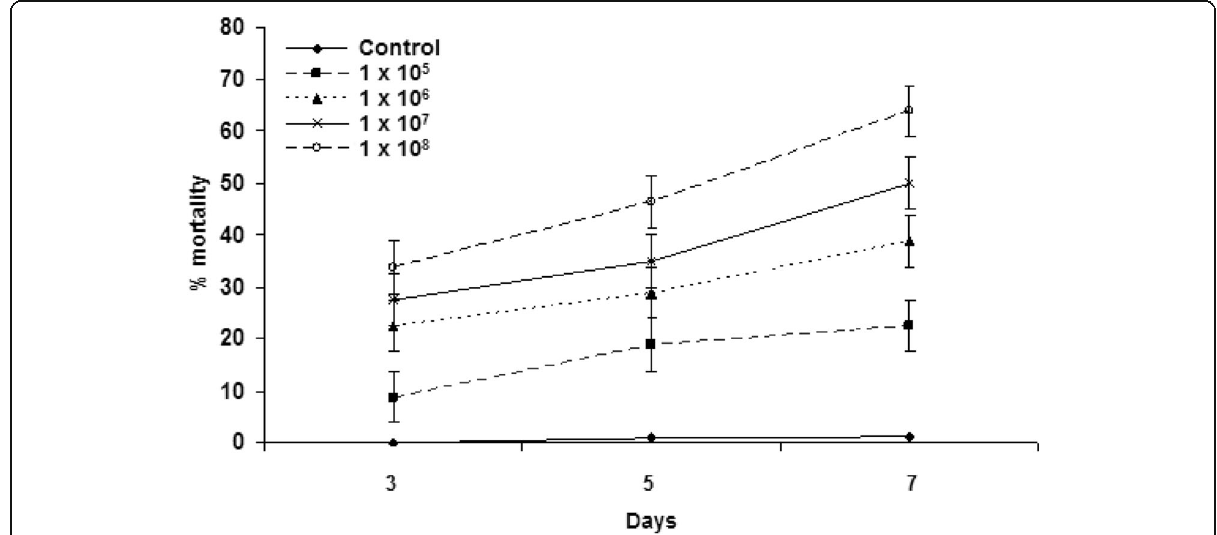
Fig. 4 Lethal effect of Trichoderma harzianum isolate against Tetranychus urticae after treatment with conidial suspensions at concentration 1